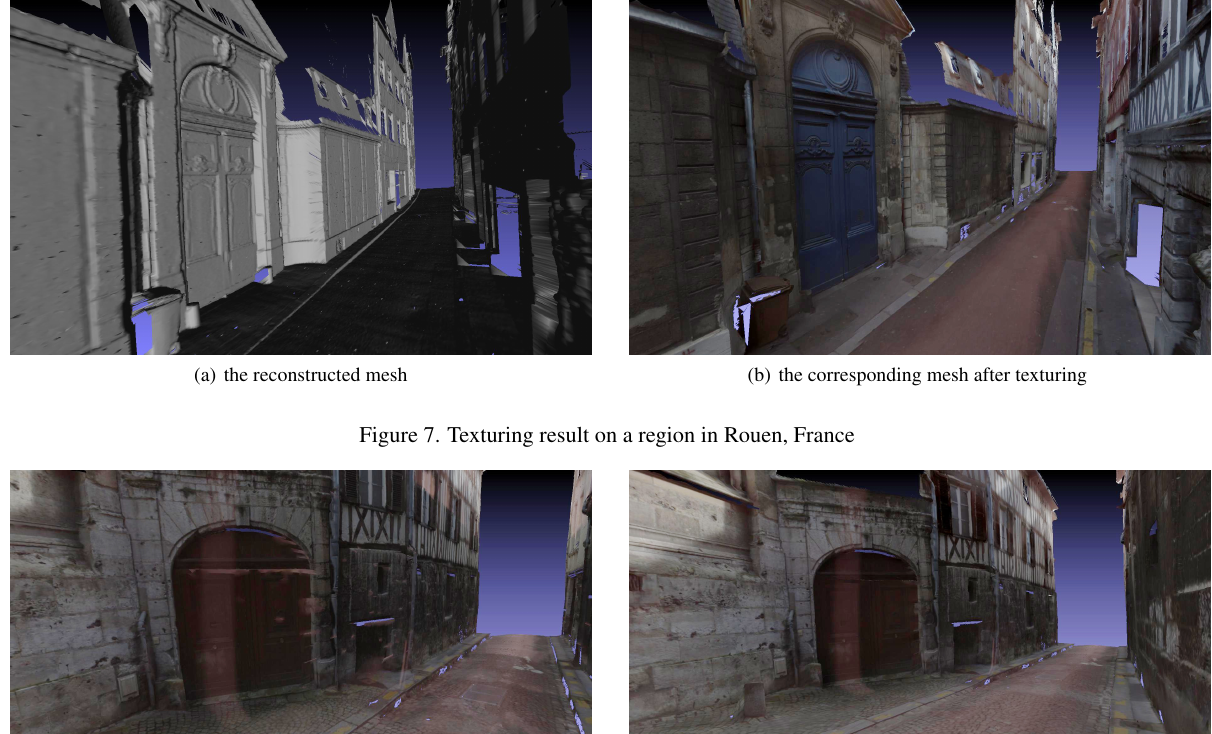
Figure 6. Decimation of sensor space topology mesh